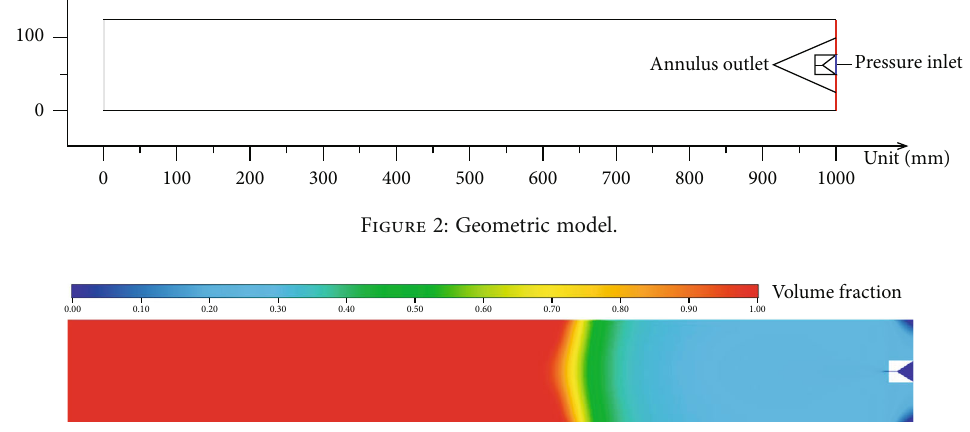
Figure 3: Methane volume fraction in wellbore.